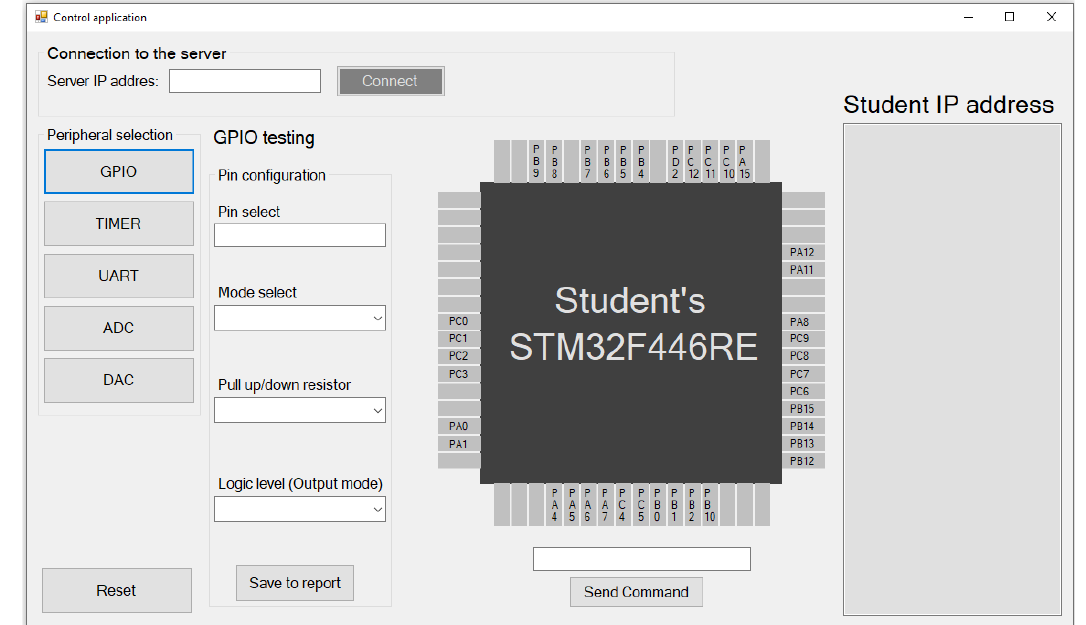
Figure 5. The control application in its start screen — GPIO testing.